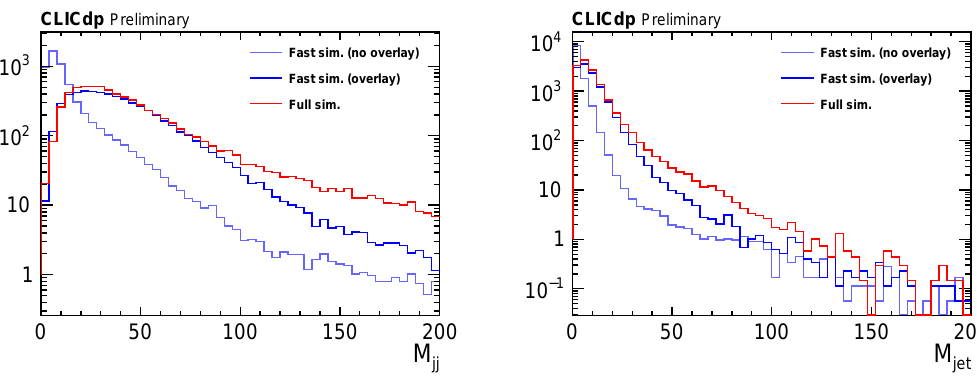
(cid:112) s = 3 TeV. The red